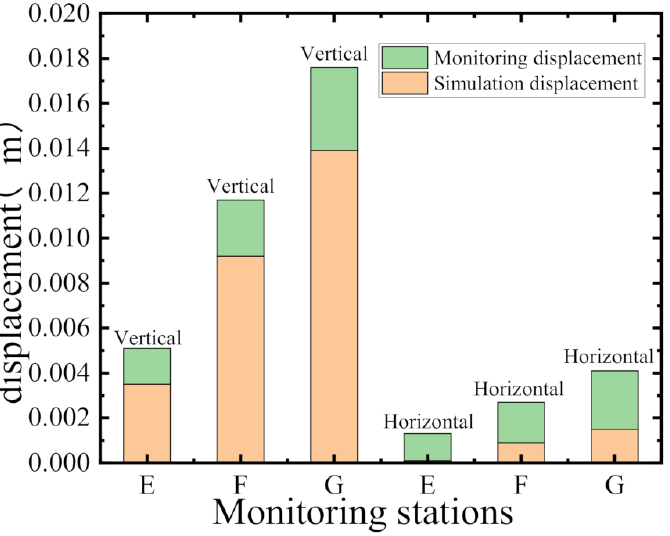
Figure 12. Simulated vertical displacement values and actual vertical displacement-monitoring